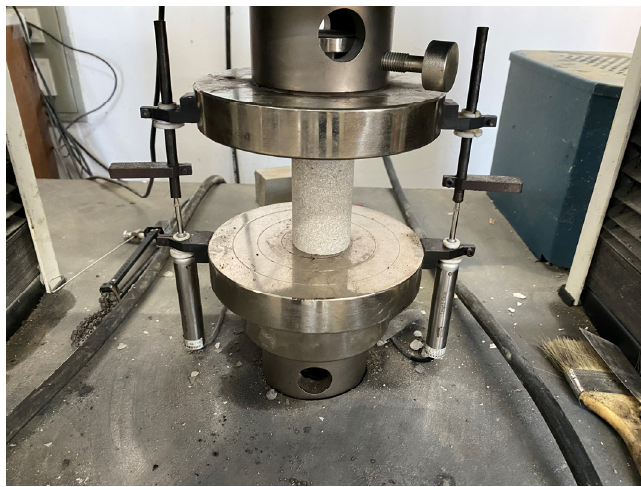
Figure 2. Sandstone cyclic loading tester.